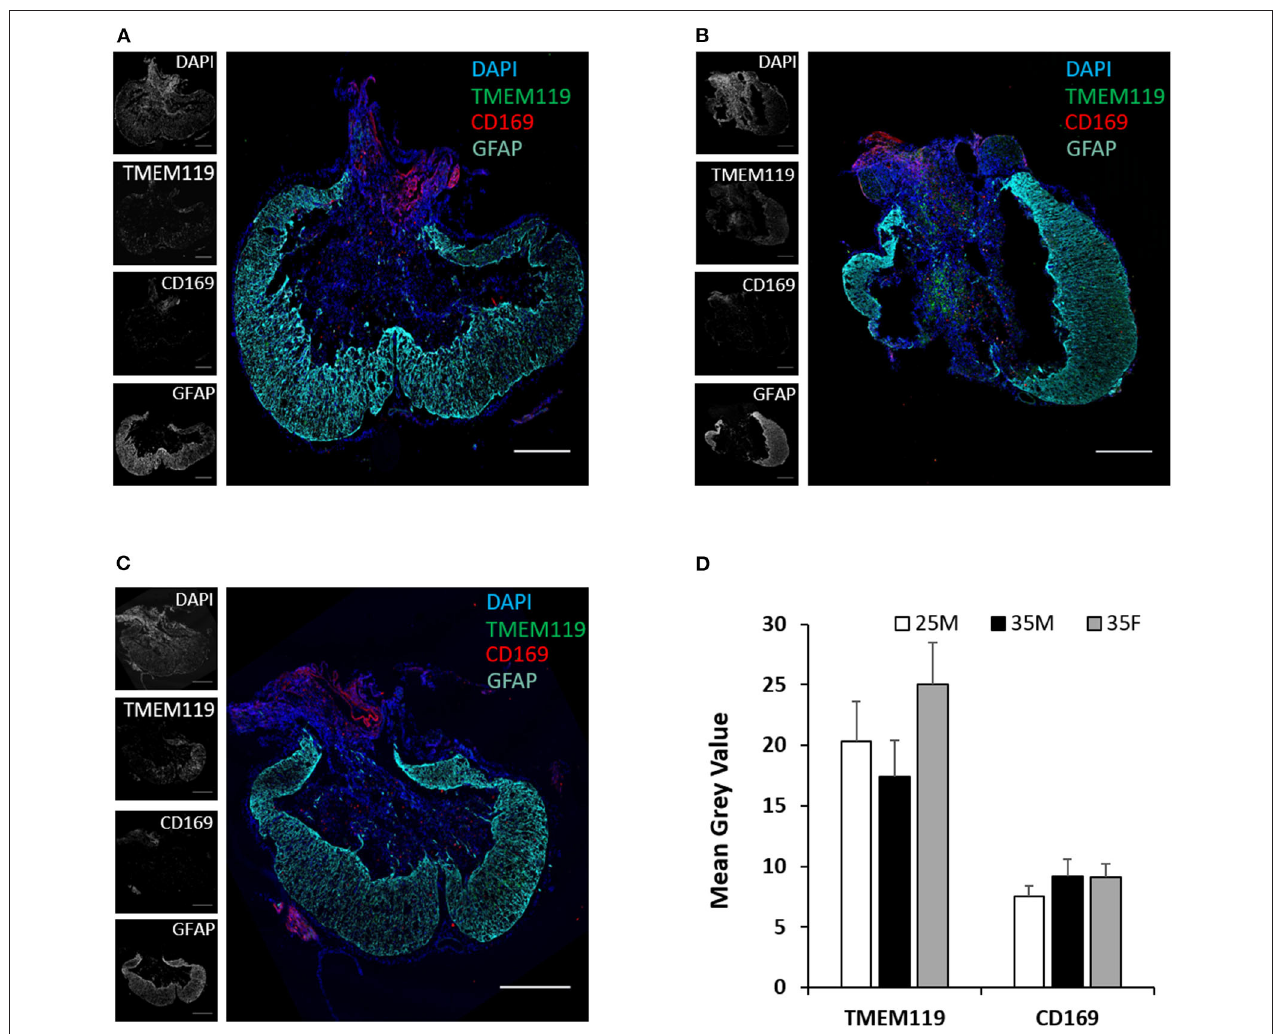
FIGURE 6 | Microglia and macrophages at the lesion epicenter following SCI. (A–C) Fluorescence images of the lesion epicenter of 25M (A) , 35M (B) , and 35F (C) groups, DAPI (blue), TMEM119 (green), CD169 (red), and GFAP (teal). (D) Quantification of fluorescence intensities of TMEM119 and CD169 at the lesion epicenter. Data are presented as mean + SEM. Scale bar shows 500 µ